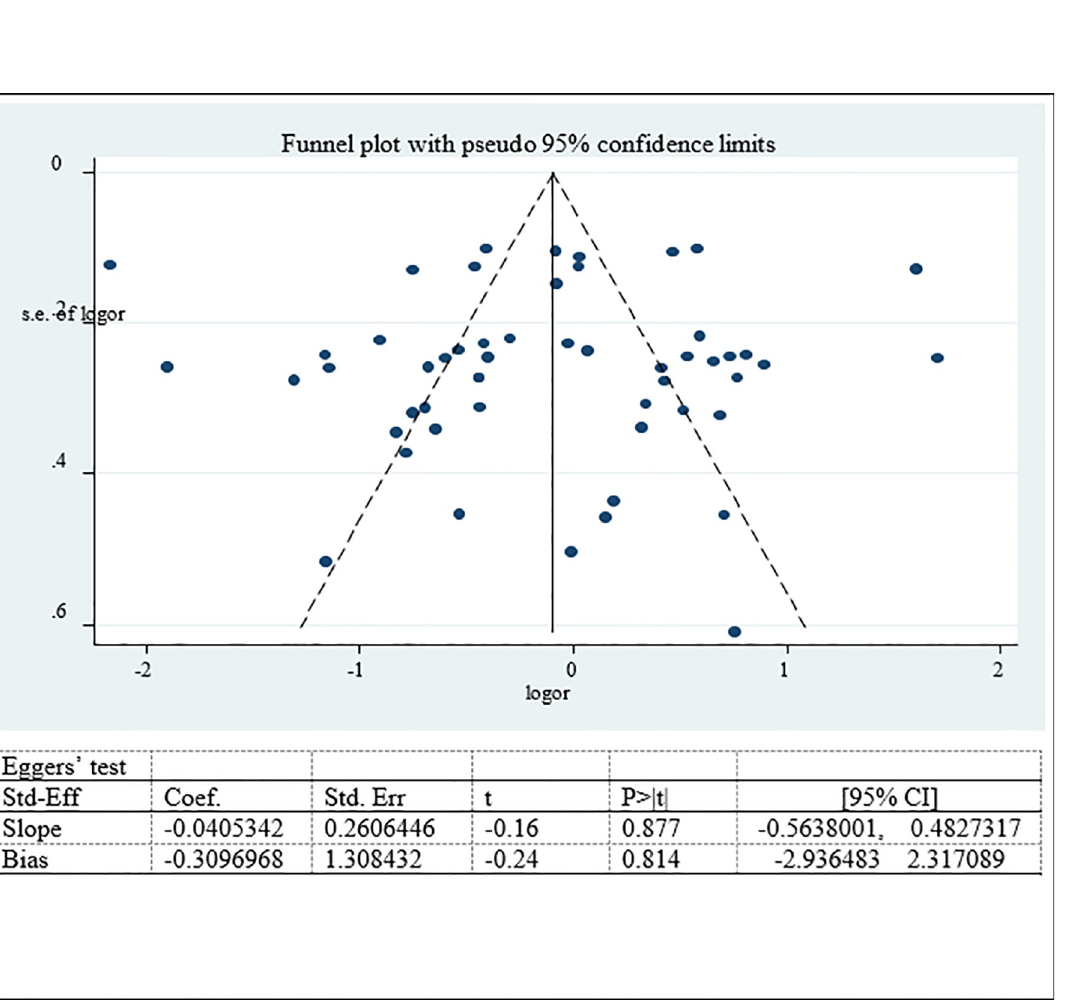
Fig 20. Funnel plot and Eggers’ test to assess publication bias for factor associated with adolescent stunting in Ethiopia.